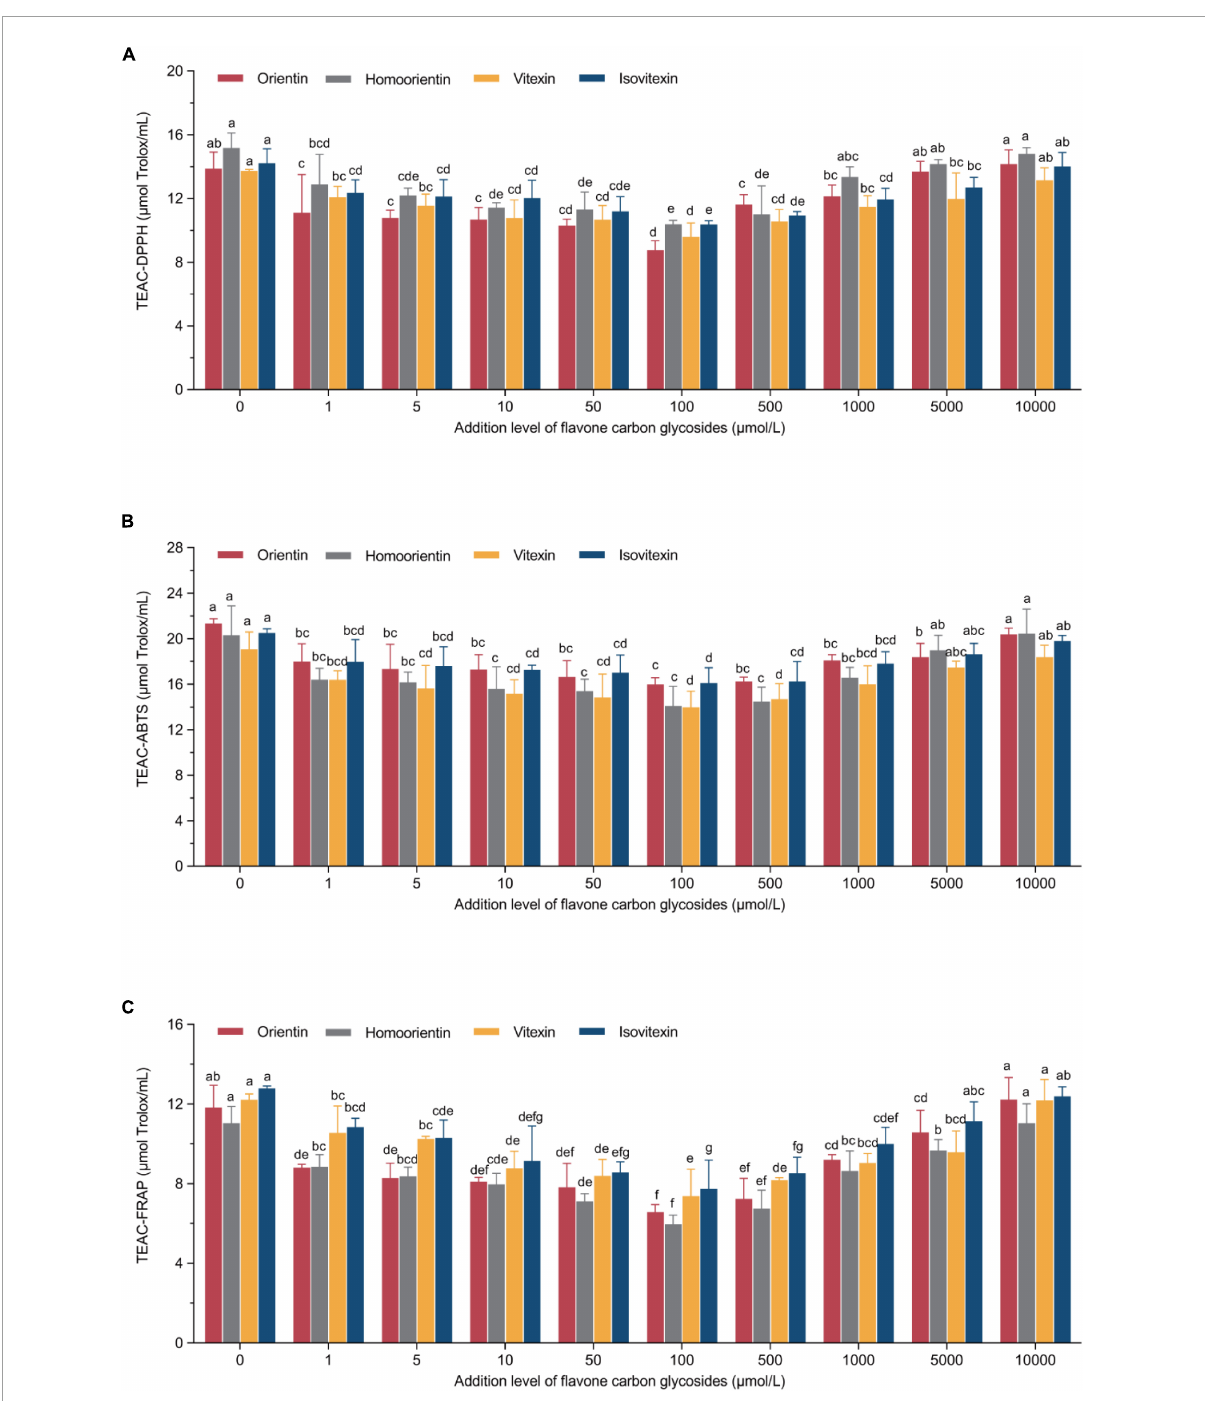
FIGURE2 U-shaped correlations between treatment levels of flavone carbon glycosides and (A) TEAC-DPPH values, (B) TEAC-ABTS values, or (C) TEAC-ferric ion reducing antioxidant power (FRAP) values in Maillard reaction products. Data are shown as the mean ± SD ( n = 3). Values with different letters indicate significant differences between different additional levels at the same flavonoid ( P <